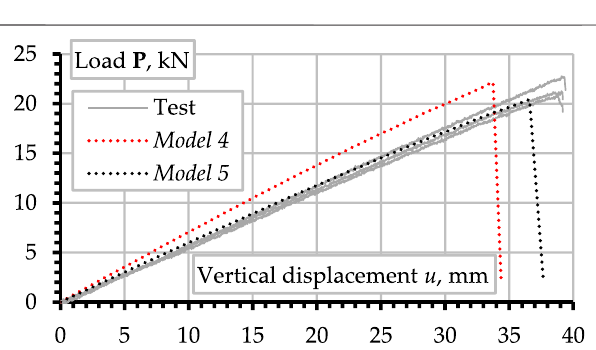
FIGURE 17 | Comparison of measured and numerically predicted load- vertical displacement diagrams at the F IBERLINE pro fi le